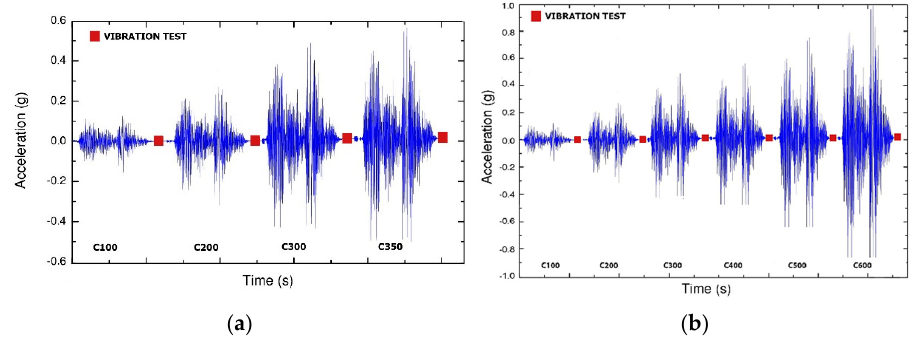
Figure 6. Accelerations of the seismic simulations applied to the structures FD ( a ) and SD ( b ). Four dampers were installed on the FD specimen, which consisted of two frames, each having two dampers, on the ground and first floors. Dampers on the ground floor had 10 I ‐ sections, while dampers on the first floor had eight sections. To save time and cost, only six I ‐ sections were instrumented with piezoelectric sensors. Four of them corresponded to the dampers of one frame (two on each floor) and the other two corresponded to the dampers of the other frame (one on each